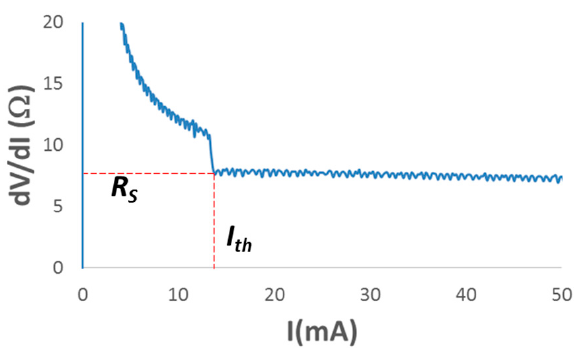
Figure 5. Plot of the dV / dI values for the same laser diode of Figure 2. The coordinates of the sharp transition individuate the threshold current I th and the series resistance R S . Note: The small decrease of the dV / dI curve after the threshold is due to geometric effects (progressive widening, after threshold, of the area of the inverted region), analyzed and explained in ref. [67]. On a practical note, it is the R S value measured at threshold to be considered.